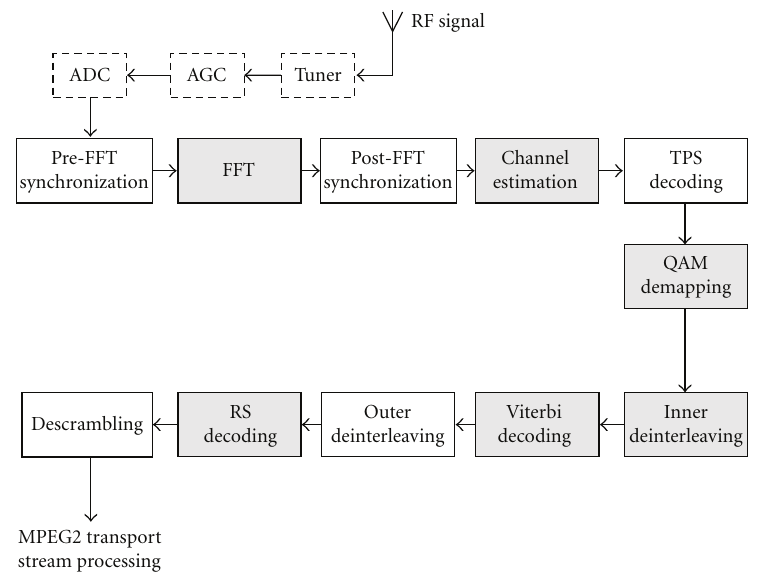
Figure 1: Functional block diagram of a DVB-T/H